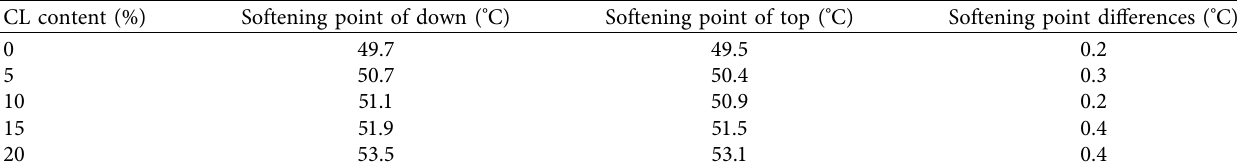
Table 8: The results of the storage stability test.